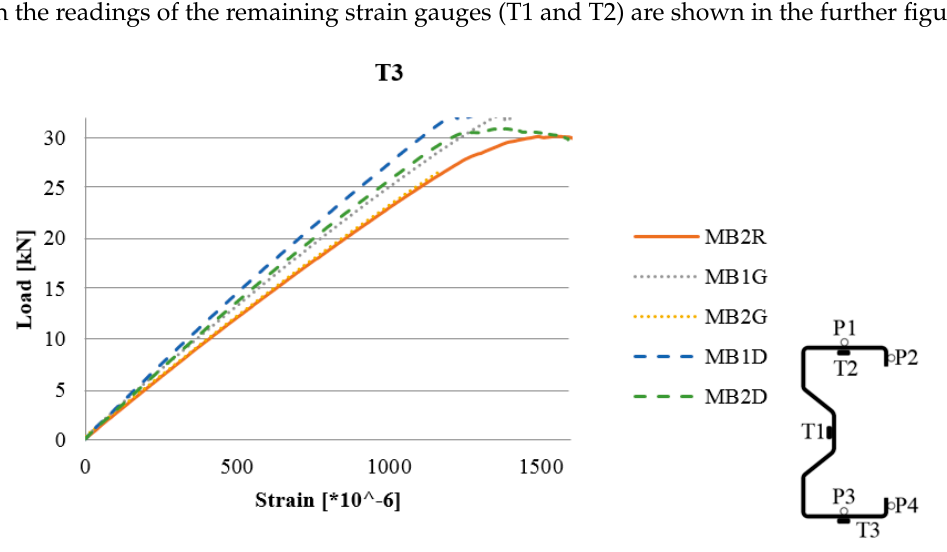
Figure 7. Load–strain diagram T3 strain gauge reading.